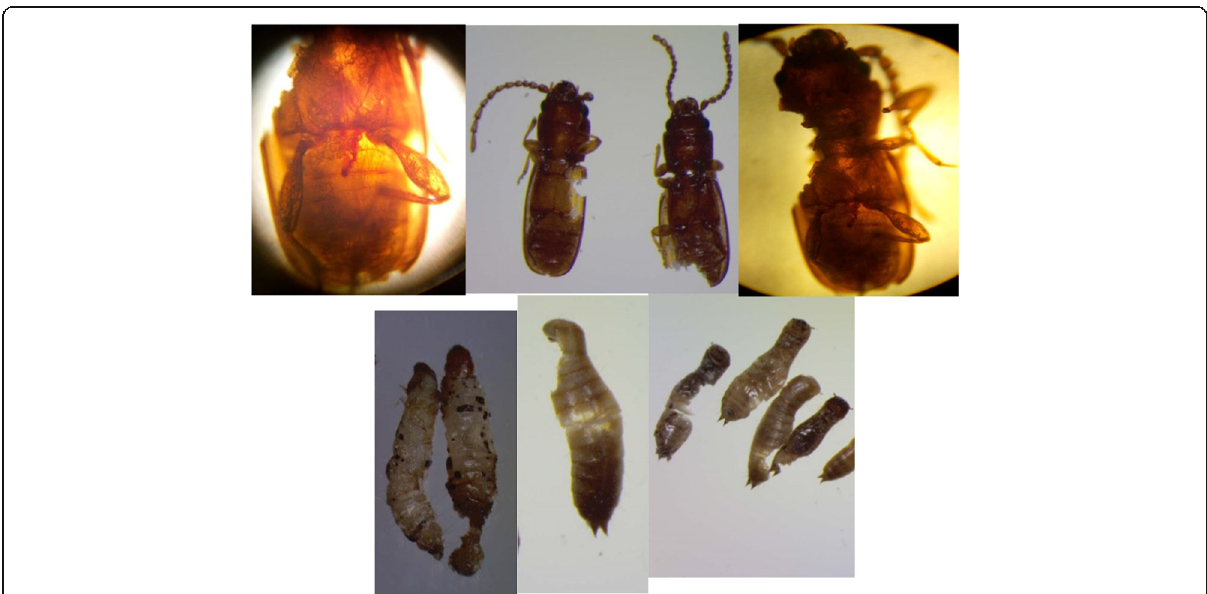
Fig. 2 Cannibalism (scavenger feeding), among most stored product insects, as a desirable manner to acquire protozoan infection (magnification ca. × 8 – 40)